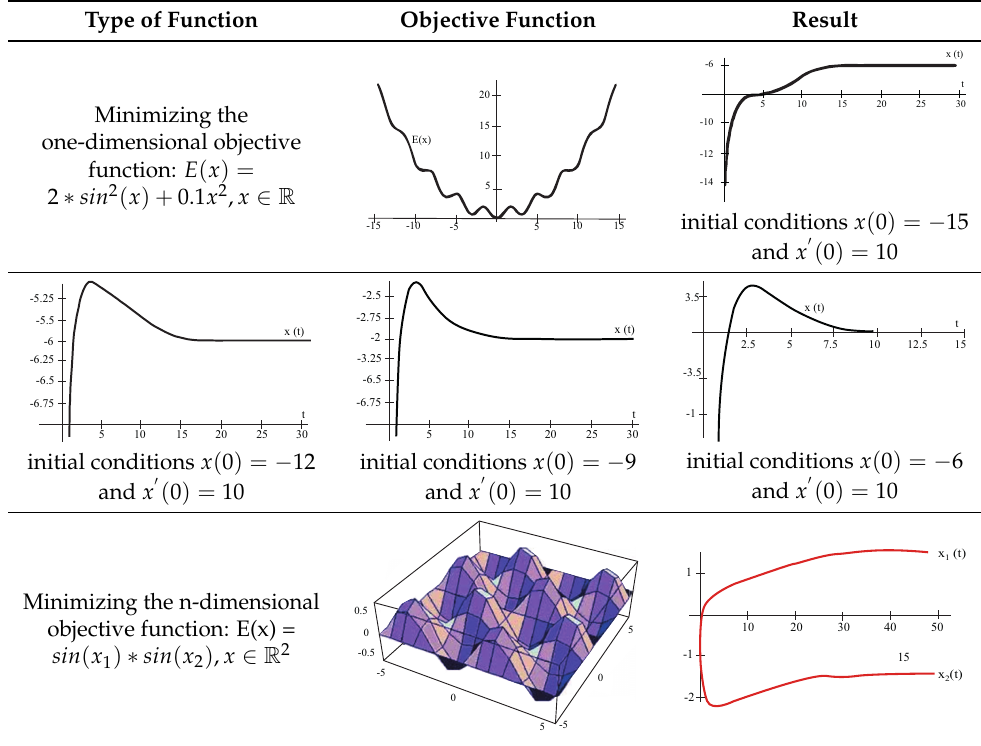
Table 1. Part One: Objective function.